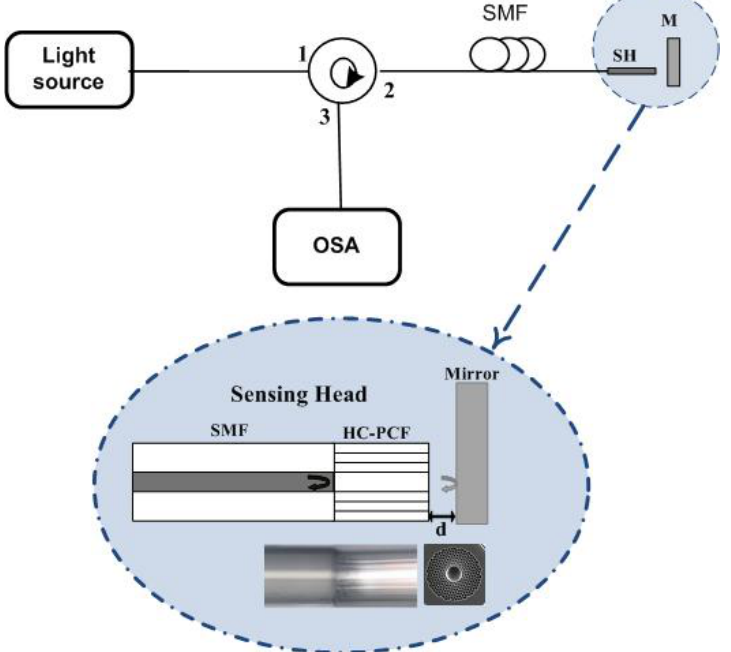
Figure 1. Schematic diagram of the set up used to measure displacement using the sensing head. Inset: drawing of the sensing head, below microscope photo of the splice zone in the sensing head, and at the right microscope photo of the cross section of the